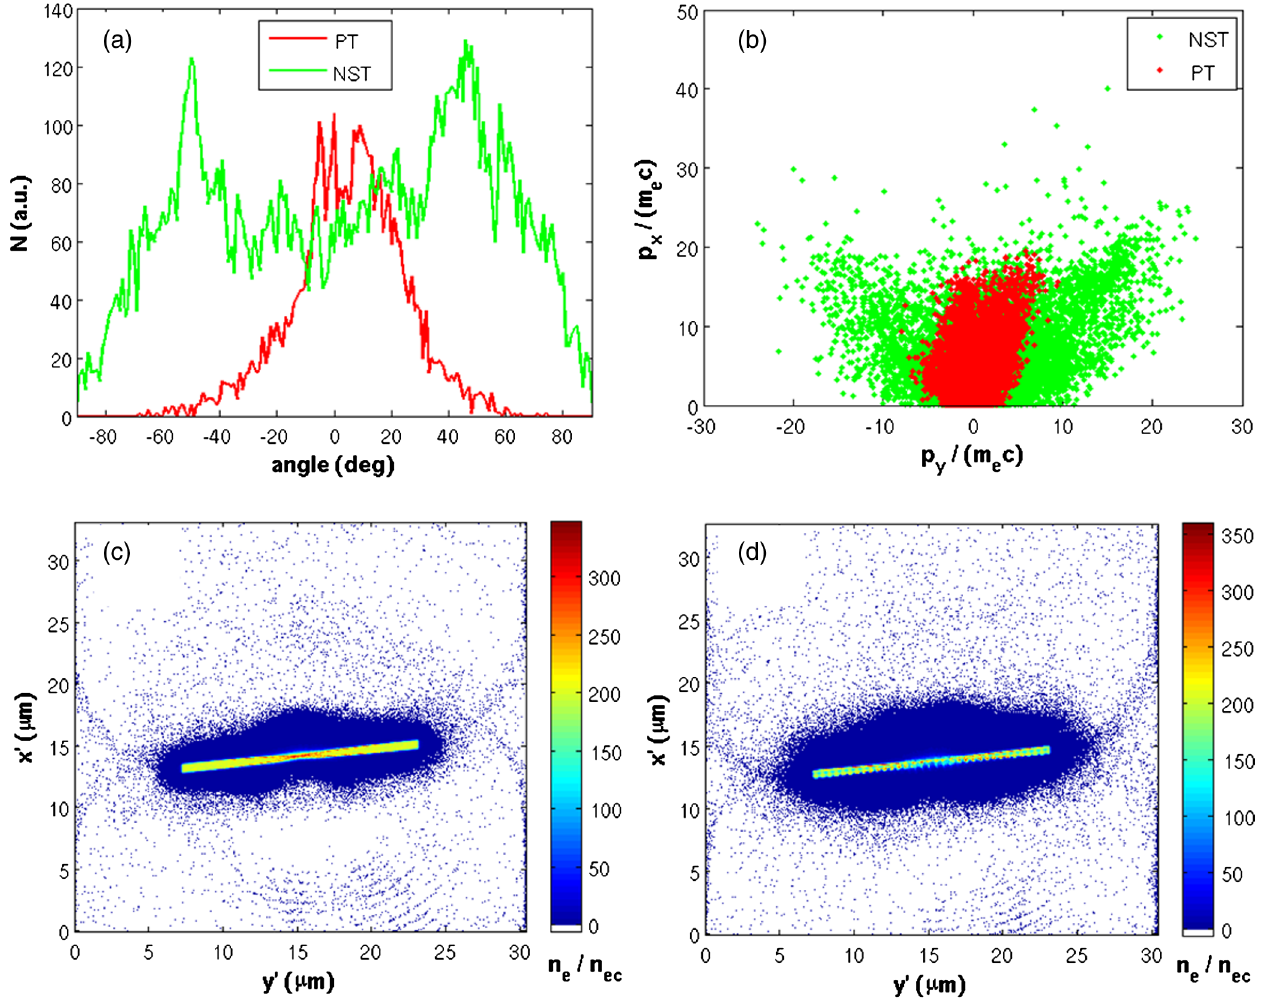
FIG. 4. (a) Angular distribution of hot electrons with energy higher than 1 MeV during laser-target interaction in the forward direction. (b) Momentum space of hot electrons in the forward direction; electrons moving along the target normal direction have a perpendicular ¼ 0 . (c) Hot electron distribution for a PT; (d) hot electron distribution for a component of momentum p y